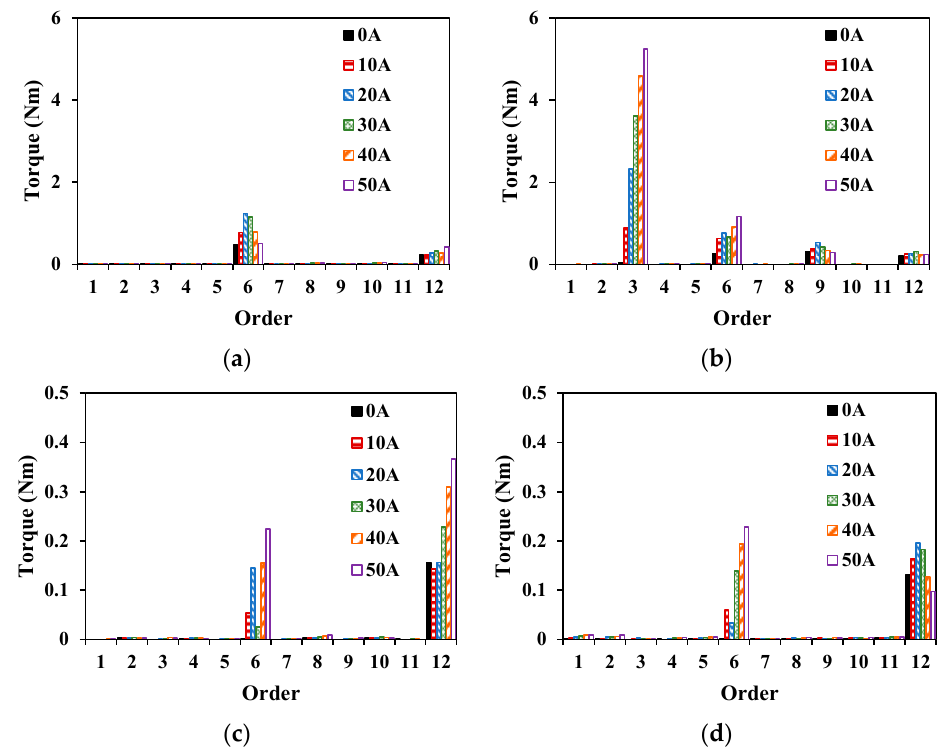
Figure 21. Torque ripple spectra for SPM and CCPPM machines. ( a ) 12s8p-SPM. ( b ) 12s8p-CCPPM. ( c ) 12s10p-SPM. ( d ) 12s10p-CCPPM.